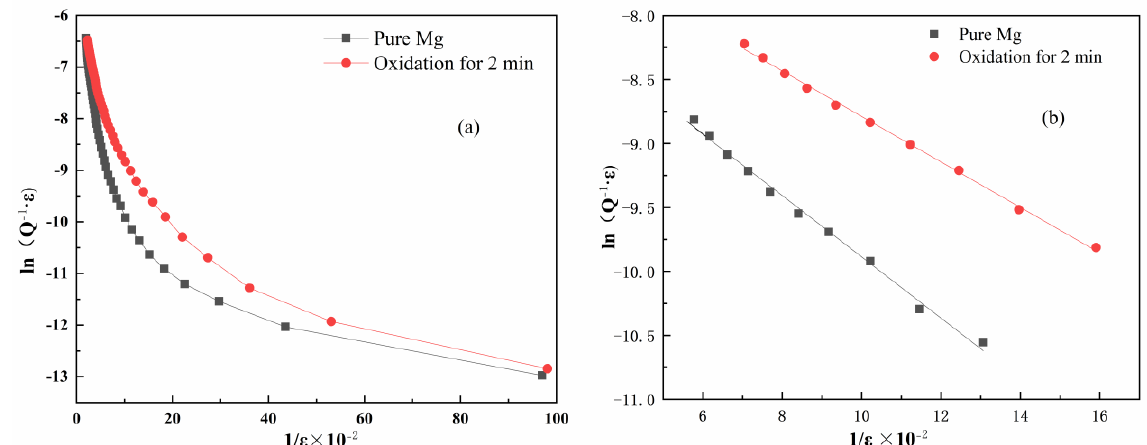
Figure 5. G – L curves of pure Mg and MgO/Mg composites: ( a ) the entire strain amplitude range; ( b ) εcr1 < ε < εcr2 .